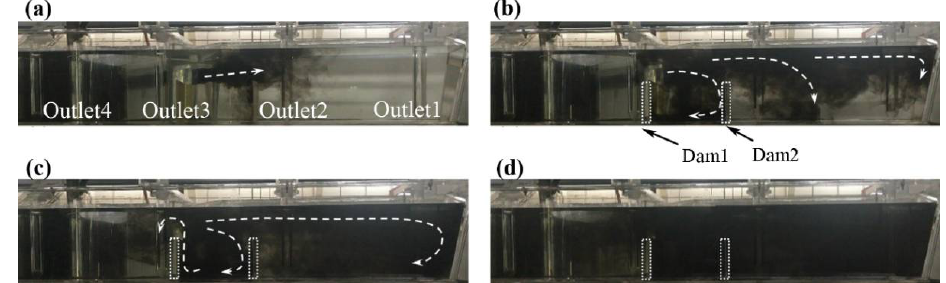
Figure 13. Ink dispersion behavior in case C5: ( a ) 33 s, ( b ) 79 s, ( c ) 135 s, ( d ) 226 s.